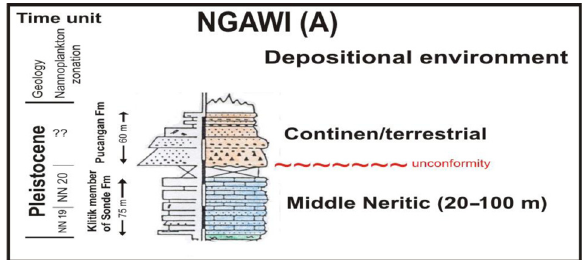
Figure 5. Pucangan and Kabuh Formations at Ngawi A [17].